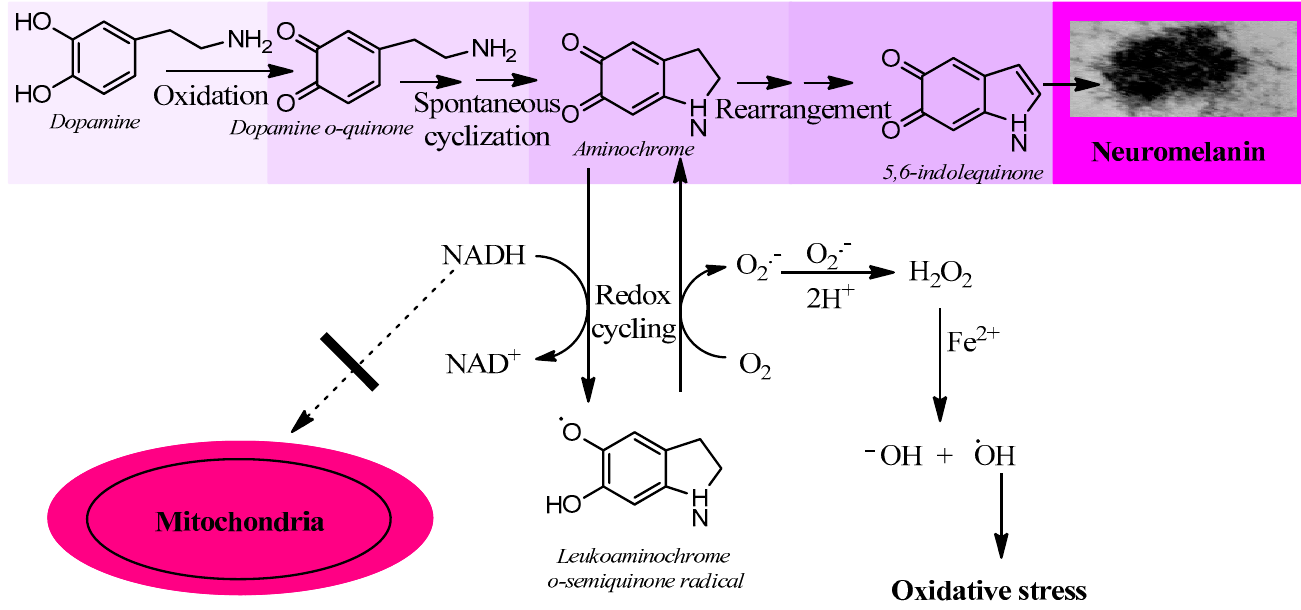
Figure 1. Aminochrome induces oxidative stress. Aminochrome can be reduced with one electron to produce the leukoaminochrome o -semiquinone radical by flavoenzymes using the cytosolic NADH generated to be used in the mitochondria to generate ATP through the transport chain coupled to oxidative phosphorylation from ADP to ATP. The leukoaminochrome o -semiquinone radical is extremely unstable in the presence of dioxygen and autoxidizes to regenerate aminochrome, which is reduced again, creating a redox cycle between aminochrome and leukoaminochrome o -semiquinone radical. This redox cycling is very fast and depletes as much oxygen as NADH with the concomitant production of oxidative stress.